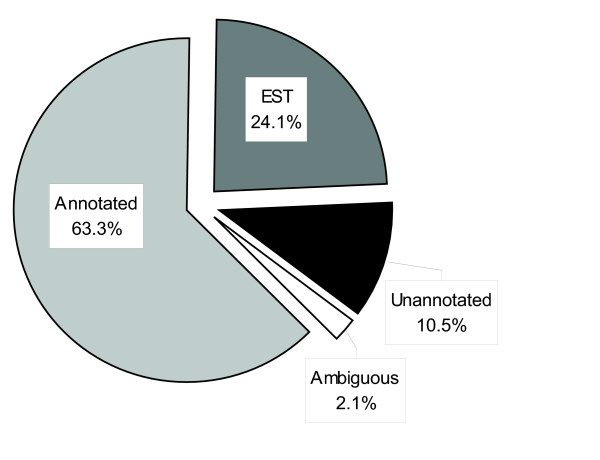
Distribution of sequence matches in the suppression subtractive hybridization clone set. The 237 non-redundant clones identified through sequence analysis of the subtractive hybridization libraries were mapped to the human genome (v. 35) and classified as representing an annotated Ensembl cDNA, a previously identified expressed sequence tag (EST), or an unannotated region of the genome. Clones not mapping uniquely to the genome were classified as ambiguous matches.